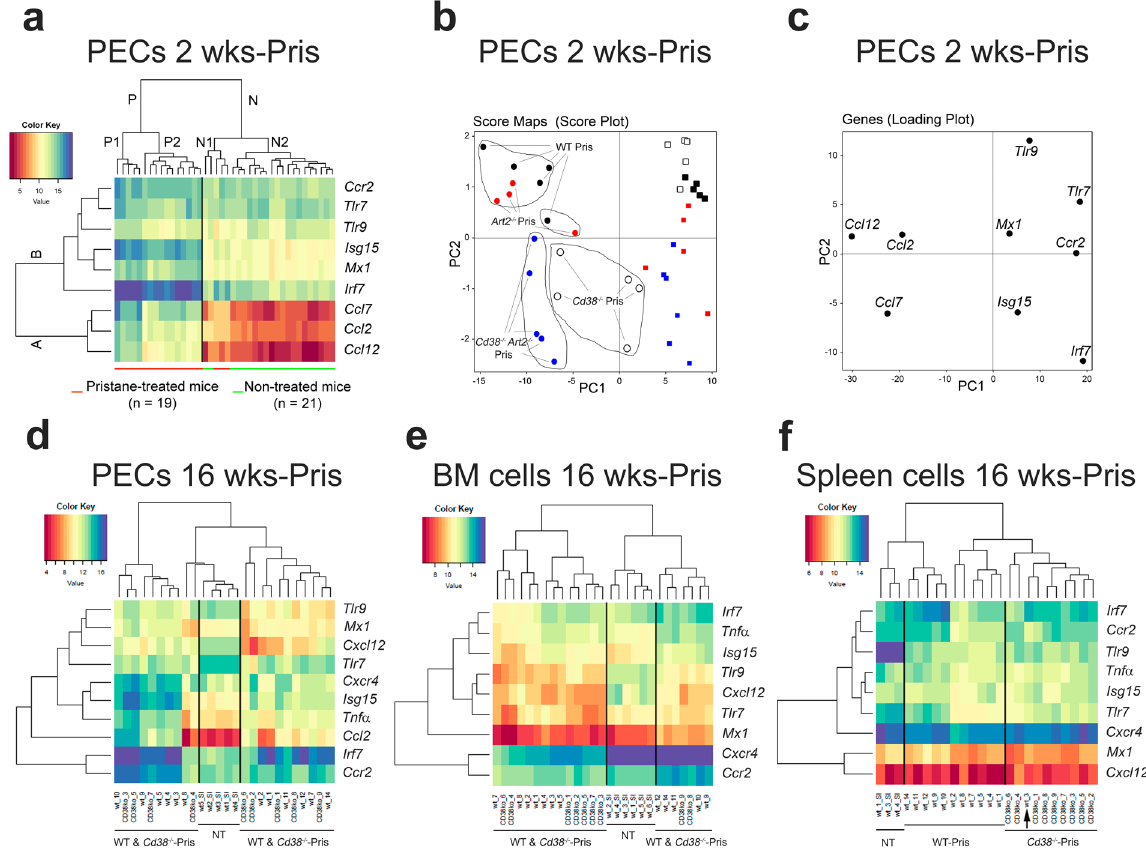
Figure 4. Distinct clustering of mice according to the expression of Type I IFN-inducible genes in pristane- treated vs. non-treated PECs. ( a ) Heat-map analysis of 9 genes, namely Ccr2 , Tlr7 , Tlr9 , Isg15 , Mx1 , Irf7 , Ccl7 , Ccl12 and Ccl12 , whose expression was useful in discriminating 2-weeks pristane-treated (cluster P) from control non-treated WT mice (cluster N). Gene expression profiles were separated into 2 major clusters (A and B), and each of them was further sub-dived into minor clusters according to expression pattern. ( b ) Principal Component Analysis (PCA) on the 9 selected genes showing a distinct expression profile in 2-weeks pristane- treated vs. control non-treated mice. The score plot shows a spot map of the 40 mice tested (black circles: pristane-treated WT; black squares: non-treated WT; open circles: pristane-treated Cd38 − / − ; open squares: non- treated Cd38 − / − ; red circles: pristane-treated Art2 − / − ; red squares: non-treated Art2 − / − ; blue circles: pristane- treated Cd38 − / − Art2 − / − ; blue squares: non-treated Cd38 − / − Art2 − / − ) projected onto the first two principal components. The drawing lines highlight the clustering of mice of the same genetic background in distinct subareas according to their distinct gene expression profile in response to pristane treatment. ( c ) Loading plot of the 9 selected genes with expression levels projected onto the first two principal components. The plot shows that the genes clustered in distinct quadrants according to their differential expression in the 8 groups of experimental mice tested. ( d–f ) Heat-map analyses of gene expression in PECs ( d ) BM cells ( e ) and spleen cells ( f ) from 16-weeks pristane-treated WT and Cd38 − / − mice compared to their non-treated WT